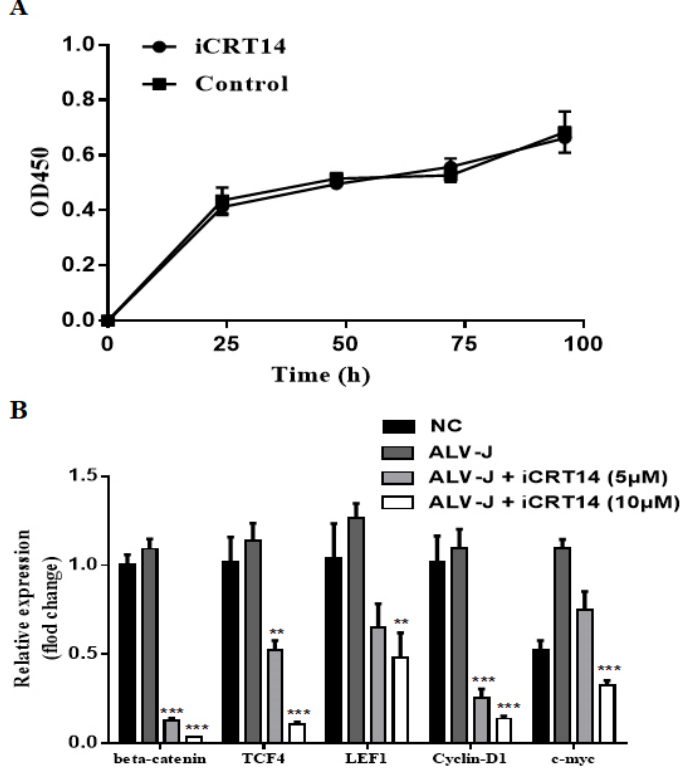
Figure 3. iCRT14 inhibited the Wnt/ β -catenin signaling pathway in CEF cells. ( A ) CEF cells were treated with iCRT14 (10 µ M) or vehicle control for various times (24, 48, 72, 96 h), and the cell viability was detected by OD450 with CCK-8 kit. Data are expressed as the mean ± SD of three independent experiments. ( B ) The gene expression levels of Wnt/ β -catenin signaling-pathway-associated genes and target genes were quantified by real-time RT-PCR. Data were expressed as mean ± SD from three independent experiments and analyzed by Student’s t -tests (** p < 0.01, *** p < 0.001). These experiments were performed independently at least three times with similar results.